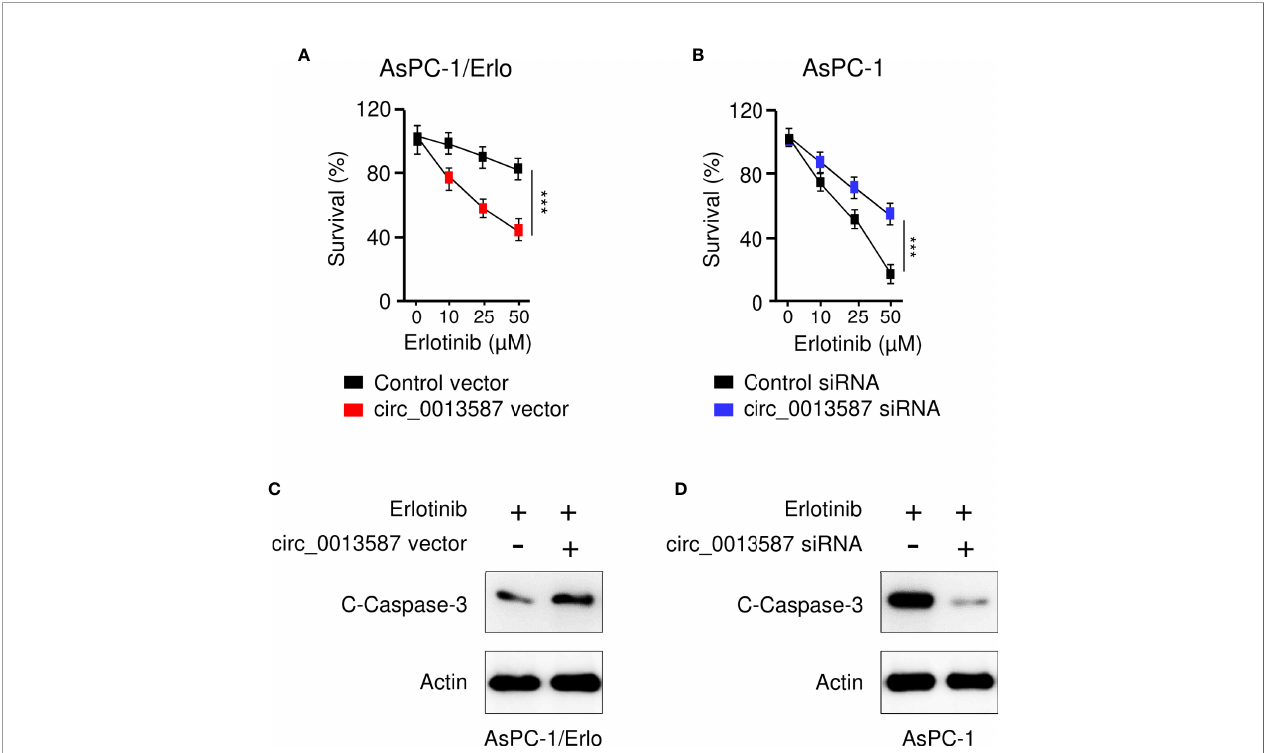
FIGURE 3 | Circ_0013587 mediates resistance to erlotinib in pancreatic cancer cells. (A) AsPC-1/Erlo cells transfected with circ_0013587 vector or control vector were exposed to each concentration of erlotinib for 48 h, and the inhibitory effects of erlotinib were evaluated using CCK-8 assays. (B) AsPC-1 cells transfected with circ_0013587 siRNA or control siRNA were exposed to each concentration of erlotinib for 48 h, and the inhibitory effects of erlotinib were evaluated using CCK-8 assays. (C) Western blot analysis of cleaved (C) -caspase-3 in AsPC-1/Erlo cells following overexpression of circ_0013587. (D) AsPC-1 cells were transfected with circ_0013587 siRNA or control siRNA and treated with different concentrations of erlotinib for 48 h The expression of cleaved-caspase-3 was determined using western blot analysis. *** P